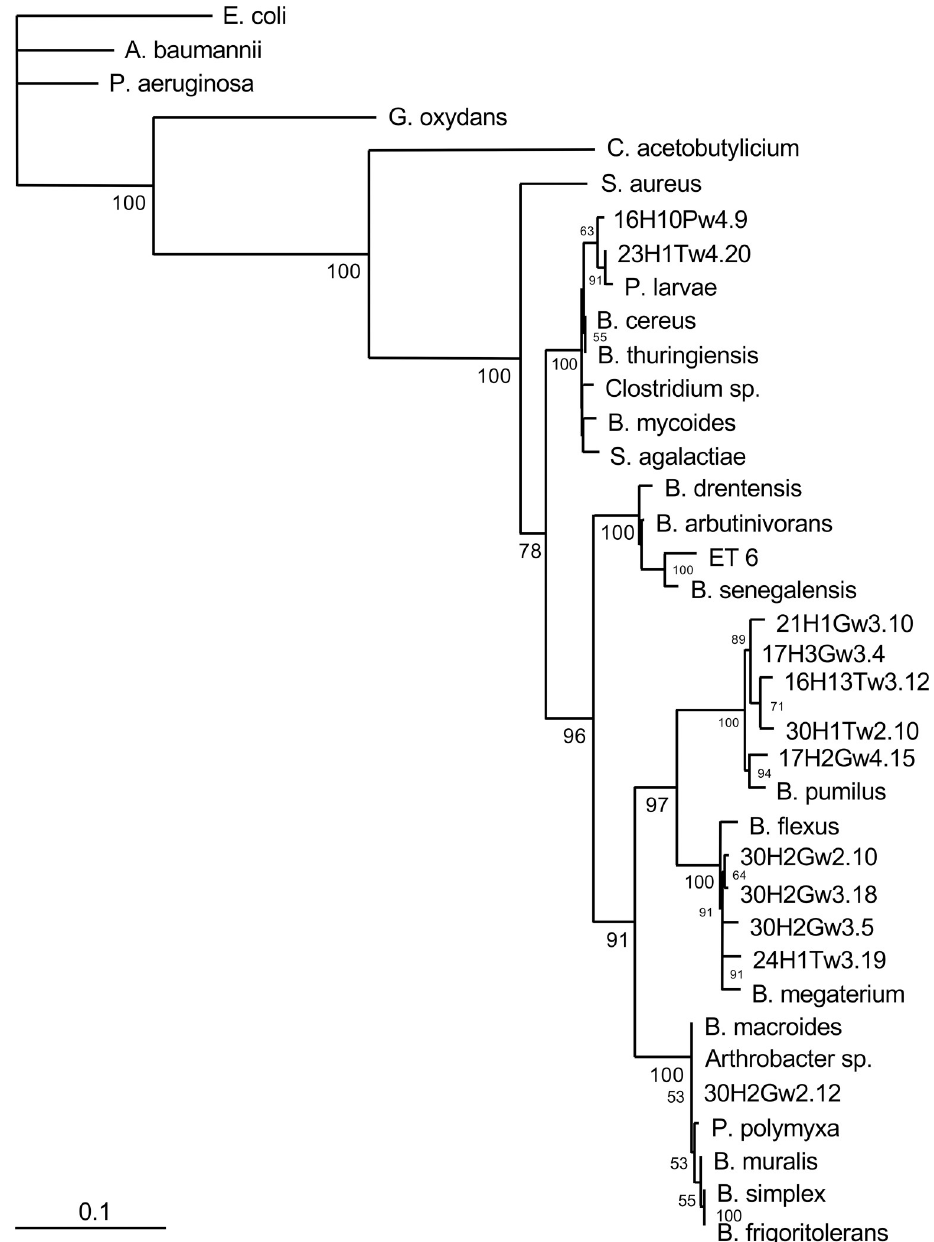
Fig 8. Phylogenetic analysis of 16S rRNA sequences (cluster I; Bacillus strains). Complementary DNA was amplified from aerobic bacteria isolated from the gut of nurse bees ( Apis millifera ) from Australia, sequenced, and sequences were aligned using the Fast Fourier Transform (MAFFT). A maximum likelihood phylogenetic tree was generated using PhyML3.0 and the general time reversible (GTR) evolutionary model. Bootstrap values detected for 100 replicates are shown near the nodes. The scale bar represents the change in nucleotides of the sequence (i.e., genetic variation for the length of scale).